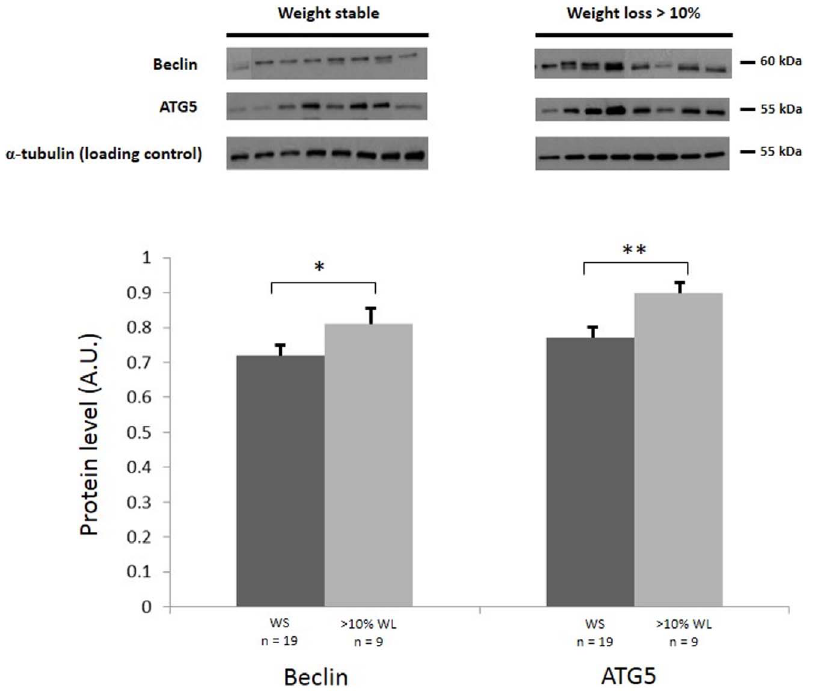
Figure 3. Skeletal muscle Beclin and ATG5 protein levels in patients with or without . 10% weight loss (Group II). Western blot analysis with indicated antibodies, a -tubulin was used as a loading control. Graph shows the mean ( 6 SEM) protein level represented in arbitrary units (A.U). (*, P , 0.05 and **, P , 0.01, by Student’s t test).